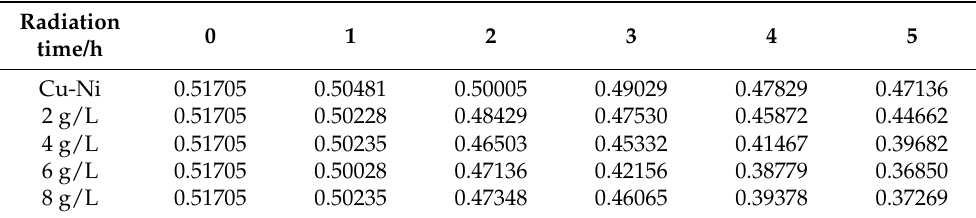
Table 4. Absorbance values of Cu-Ni-ZnO nanocomposite coatings with different (Cu, Ni)-ZnO addition under ultraviolet light